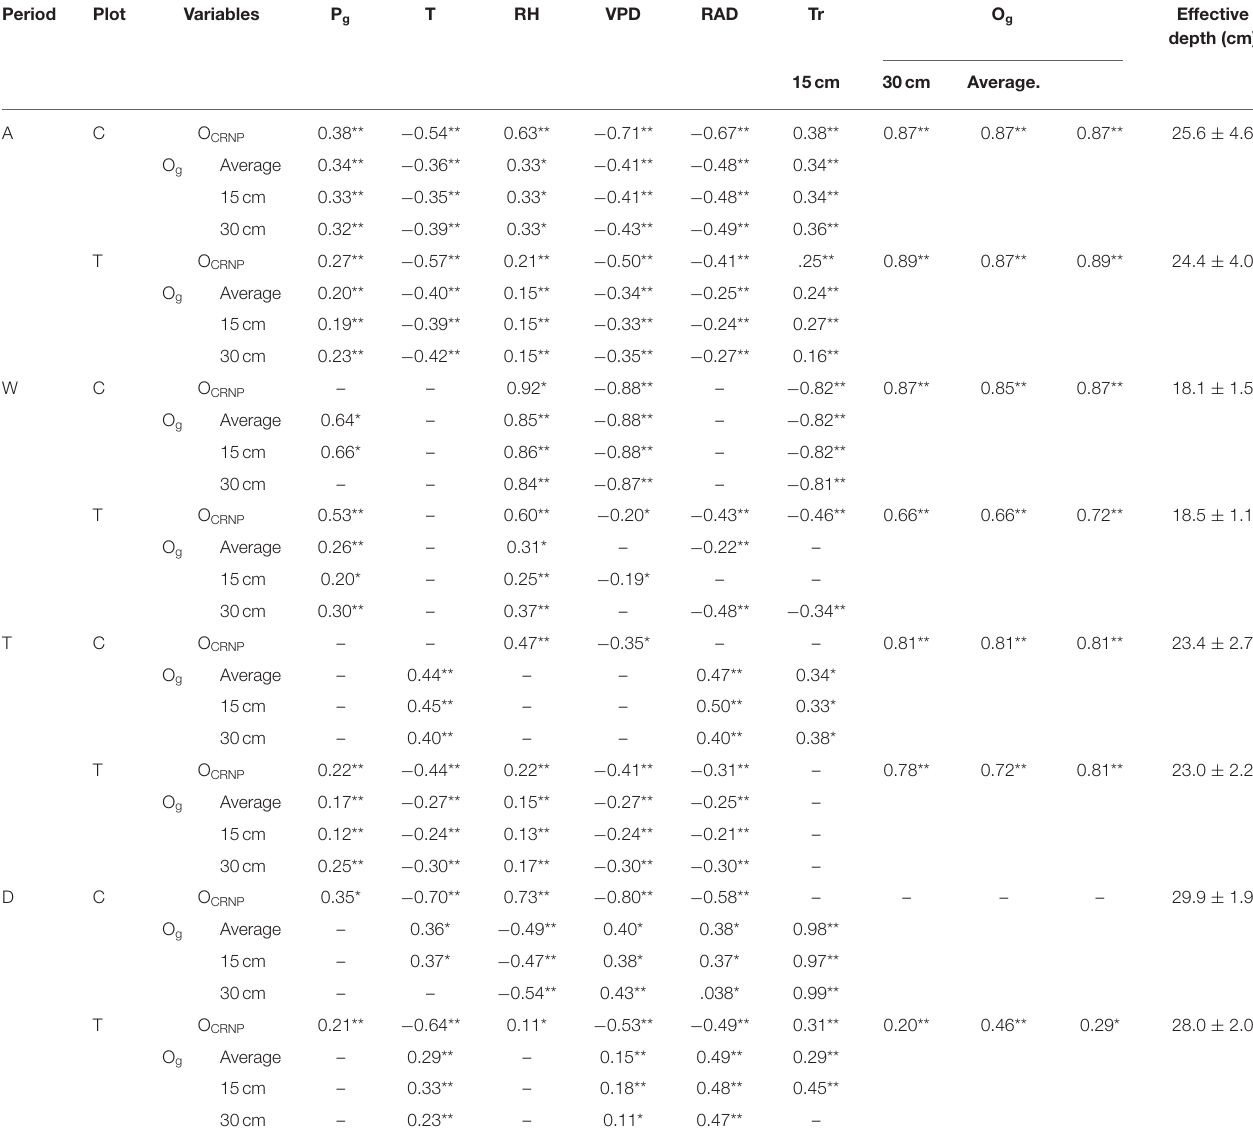
TABLE 8 | Matrix of Spearman correlations among soil water content measured with capacitance (O g ) and CSR (O CRNP ) probes and the environmental variables at thinned (T) and control (C) plots: Average temperature (Tm), Gross precipitation (Pg), accumulated precipitation (Pac), vapor pressure deficit (VPD), radiation (RAD), and stand transpiration